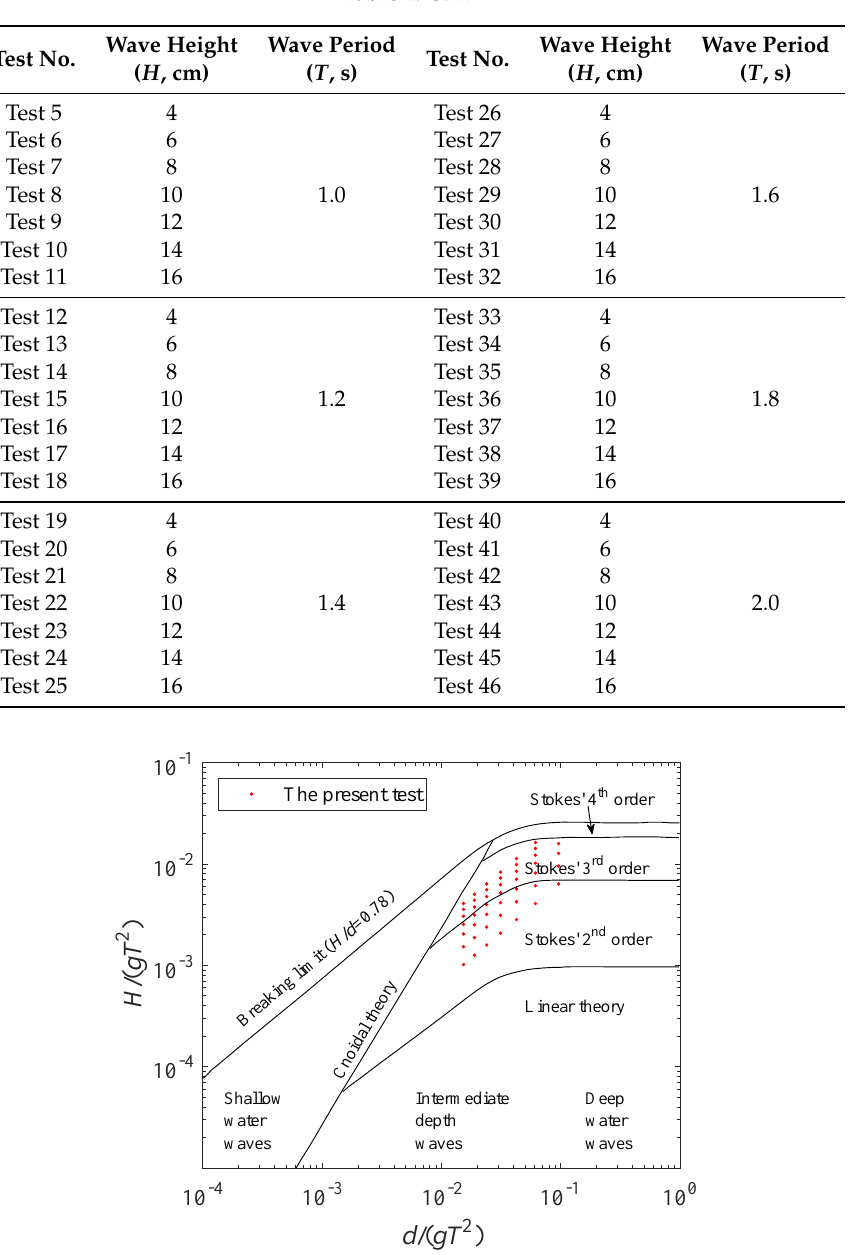
Figure 6. Range of suitability of various wave